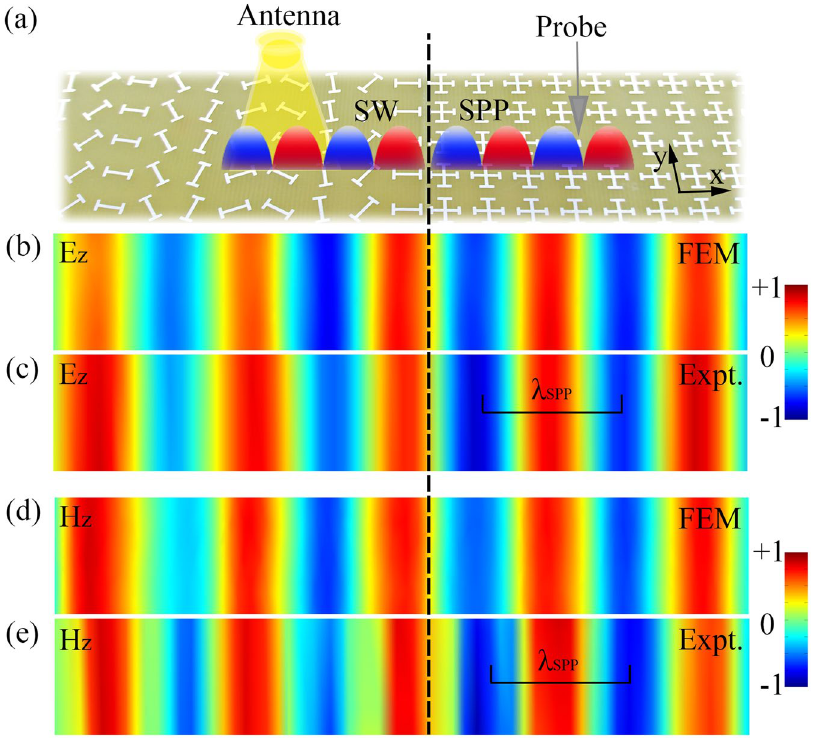
Figure 4. Near-field characterizations of the high-efficiency PB meta-coupler. ( a ) Sample picture and experimental setup to demonstrate the SPP excitation performance of the proposed PB meta-coupler. Using the RCP antenna to normally illuminate the central PB metasurface, we respectively adopted the electric and magnetic probers to measure E z ( c ) and H z ( e ) field distributions (real part) above PB meta-coupler at the frequency 10 GHz, verified well by FEM simulation results ( c , e ). Based on the same near-field mapping technique, dispersion relations of TE and TM polarized SPPs on the mushroom (open stars in Fig. 2d) are also retrieved, matching well with simulated results by FEM eigen-mode calculations (see Fig.